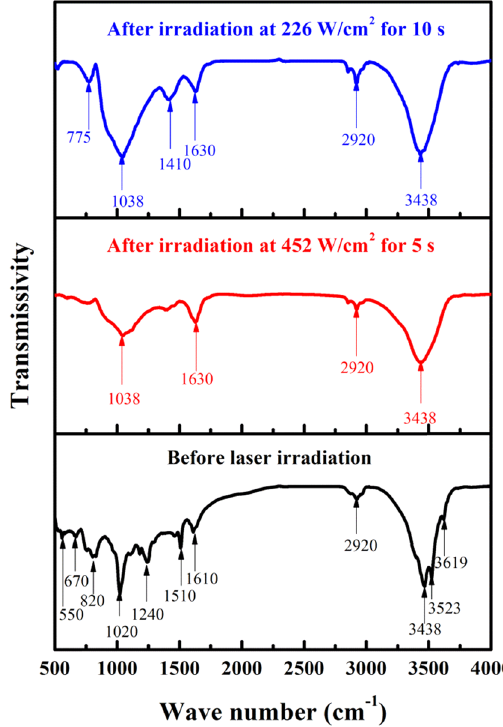
Figure 3: FTIR spectra of the quartz/epoxy composite before and after laser